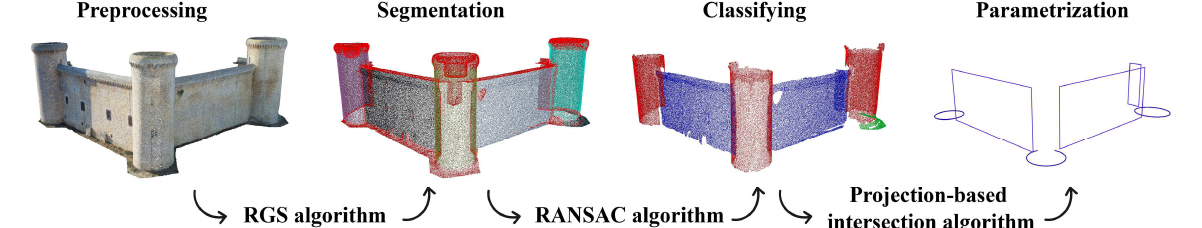
Figure 1: Overview of the proposed method. From left to right. Preprocessing; Segmentation; Classifying;